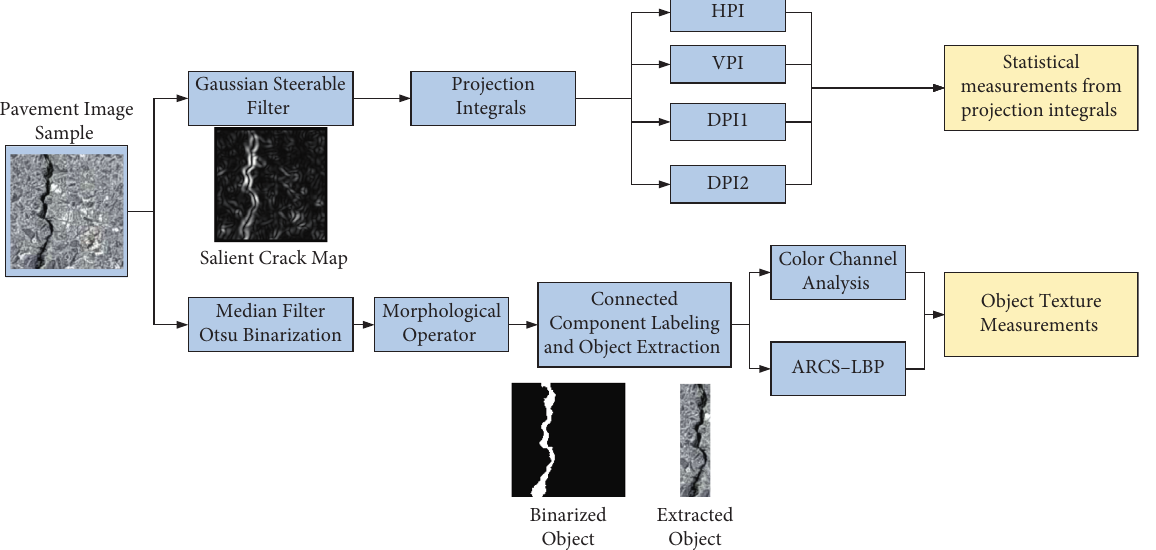
Figure 9: Illustration of the overall feature extraction